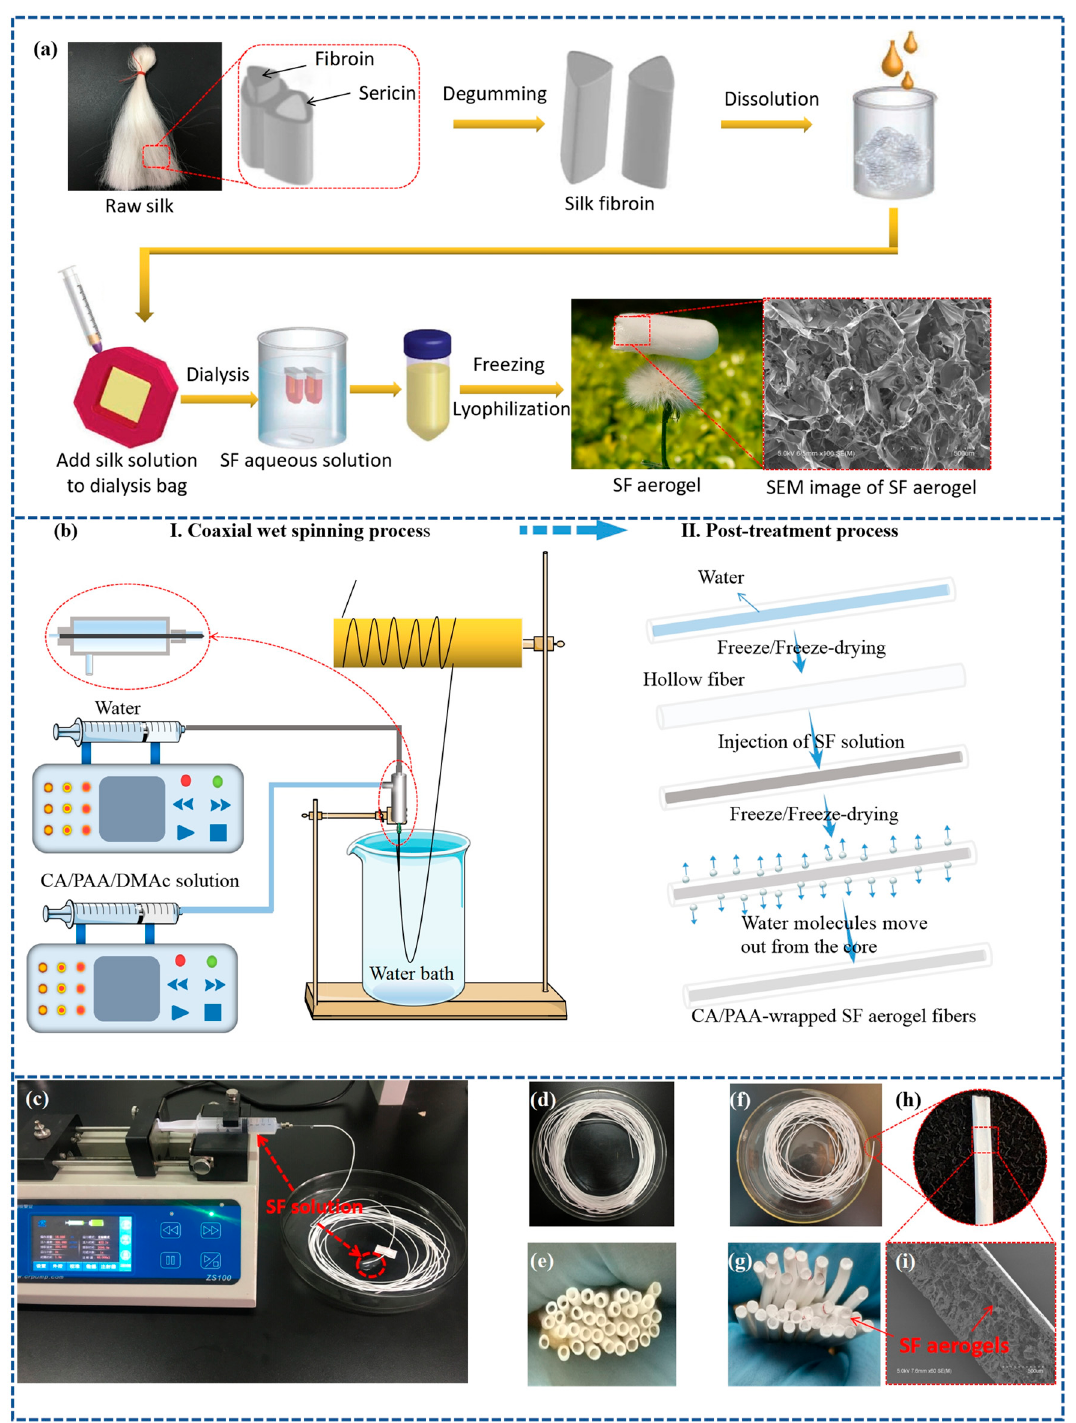
Figure 1. ( a ) Typical preparation process of 3D bulk silk fibroin (SF) aerogel. ( b ) Schematic diagram of coaxial wet-spinning of cellulose acetate / polyacrylic acid (CA / PAA) hollow fiber and post-processes to produce CA / PAA-wrapped SF aerogel fibers. ( c ) Optical image of silk fibroin solution injected into CA / PAA hollow fiber. ( d , e ) Optical image of CA / PAA hollow fibers. ( f – i ) The CA / PAA-wrapped SF aerogel fibers with arrows pointing at the exposed SF aerogel core of aerogel fiber cross-sections and longitudinal sections.